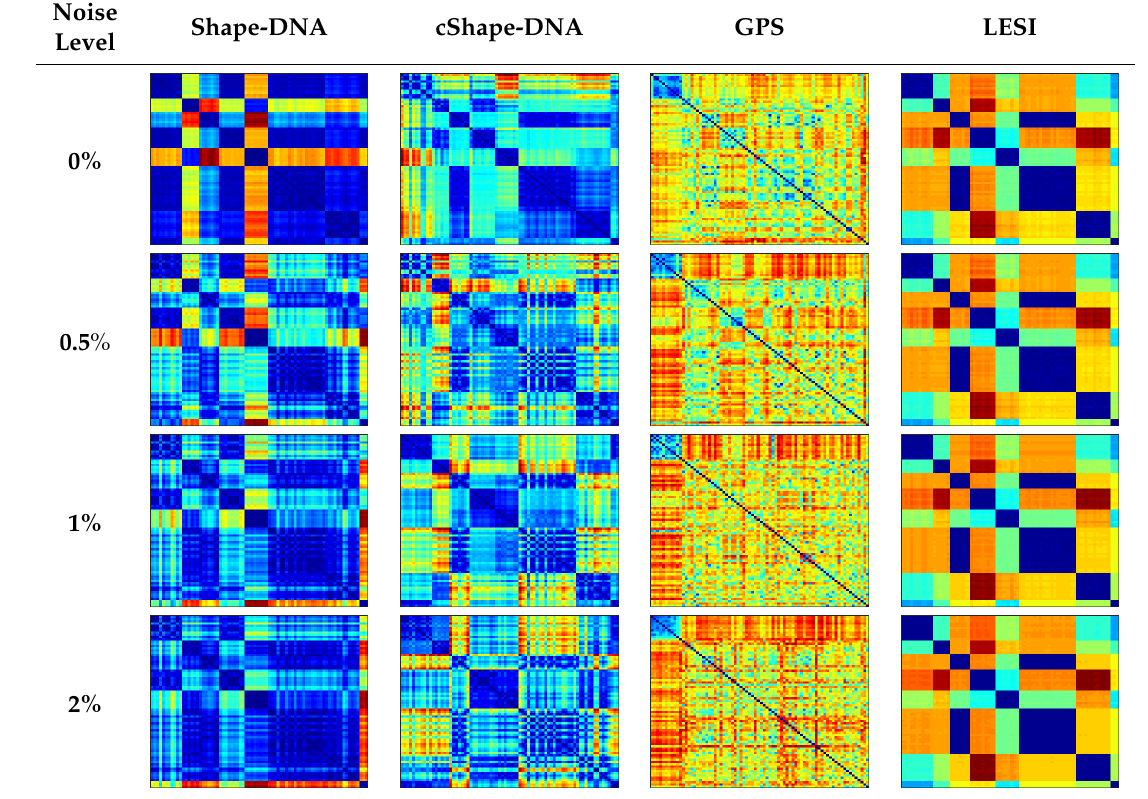
Figure 8. The Euclidean pairwise distance matrix of shape descriptors computed by (from left to right) Shape-DNA, cShape-DNA, GPS, and LESI algorithms from perturbed TOSCA dataset by (from top to bottom) 0%, 0.5%, 1%, 2% noise levels.